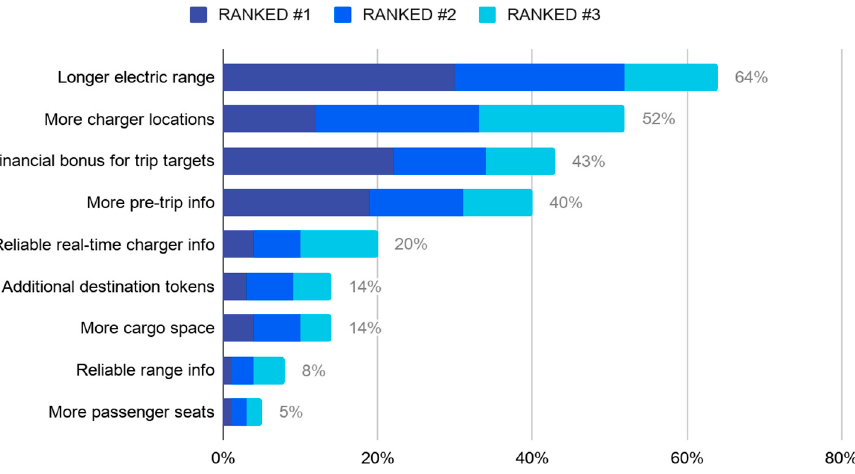
Figure 14. Driver choices to improve the experience of driving PEVs on TNCs; up to three answers allowed.